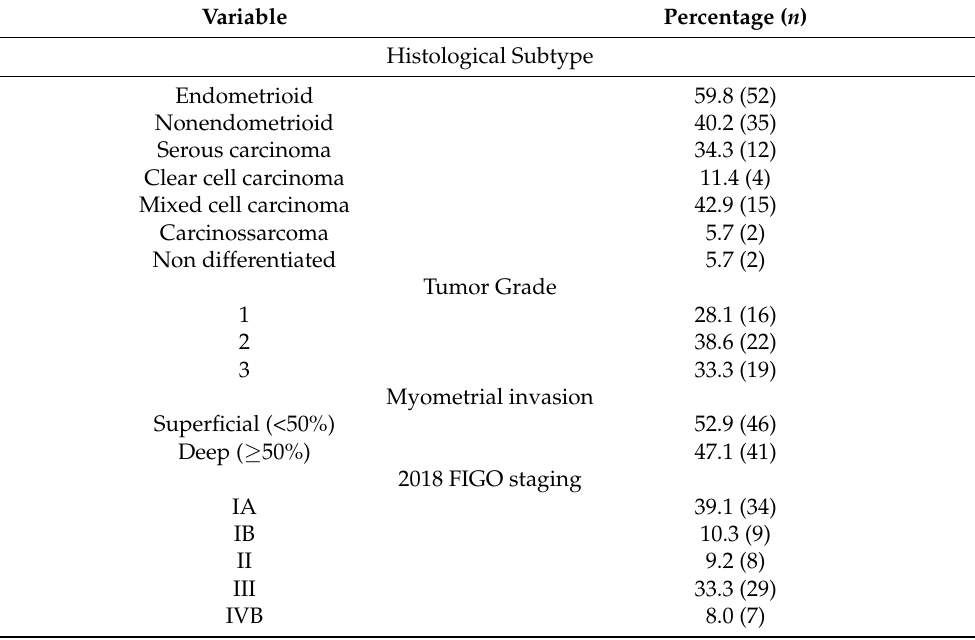
Table 1. Surgical histopathological results.